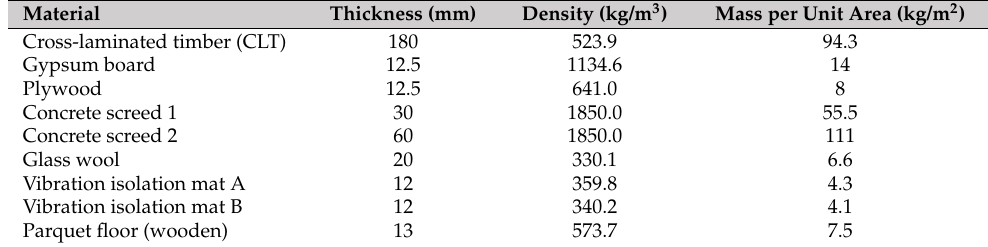
Table 1. Overview of material properties of the study.